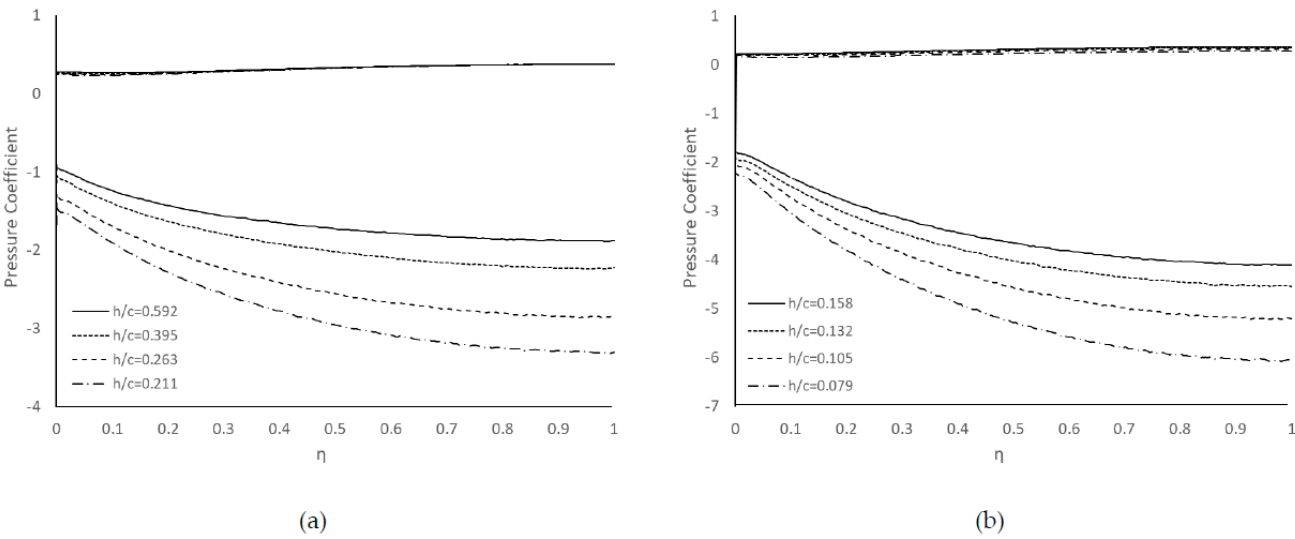
Figure 9. Spanwise surface pressure on main element: ( a ) large heights, ( b ) small heights.